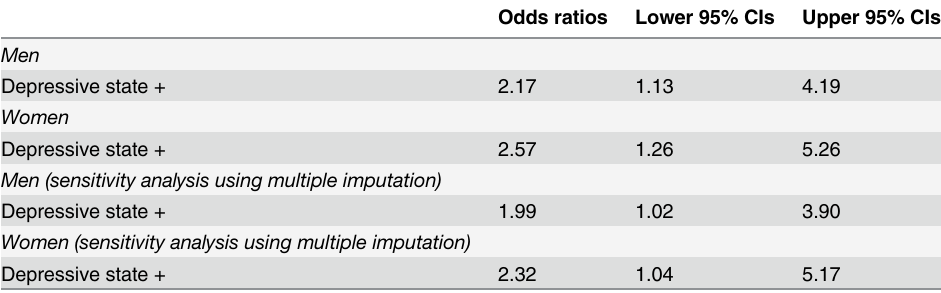
Table 4. Marginal odds ratios by logistic models with depressive status as the exposure and impaired HLFC as the outcome using IPTW with propensity scores † in men (n = 233) and women (n =